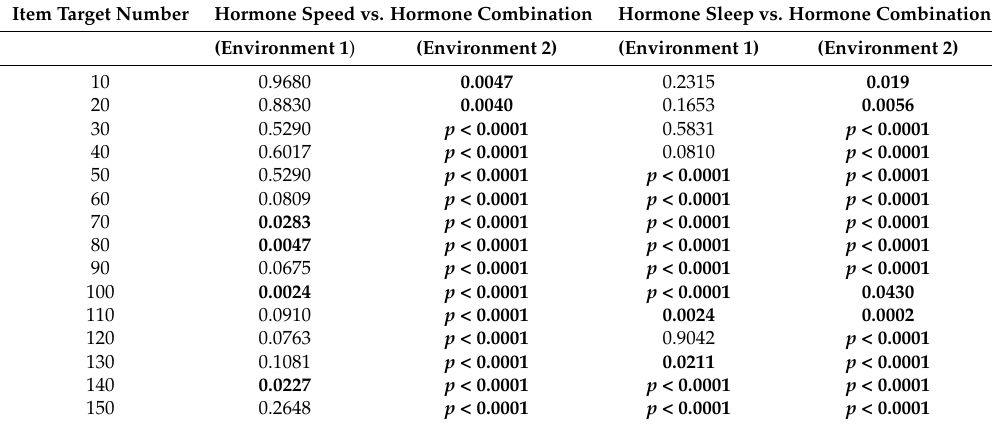
Table 5. Wilcoxon rank sum tests comparing the combined hormone system with both the speed hormone system and the sleep hormone system, in both of the previously established environments. Tests were conducted for item collection targets between 10–150 in terms of energy efficiency. Significant differences (indicated by a p value of <0.05) are highlighted in bold